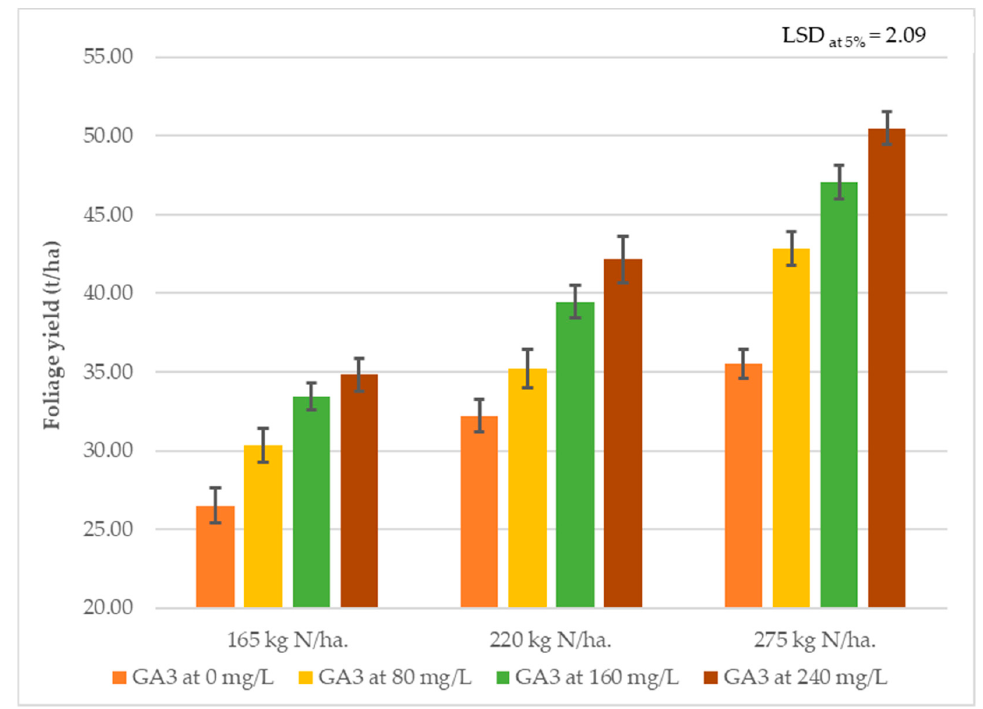
Figure 7. Foliage yield (t/ha) as affected by the interaction between nitrogen fertilizer levels and GA 3 spraying concentrations in the first season (2014/2015).